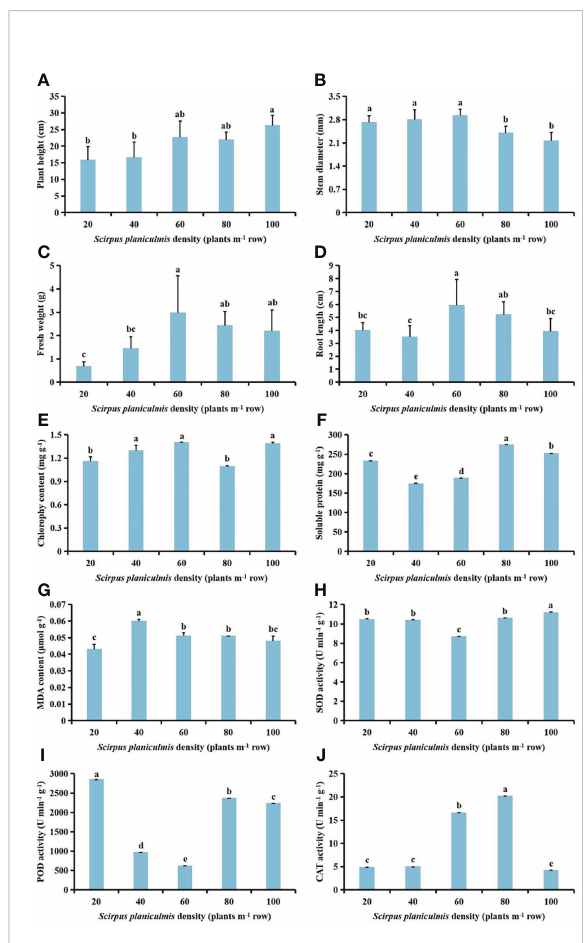
FIGURE 1 Effects of different Scirpus planiculmis densities on (A) plant height, (B) stem diameter, (C) fresh weight, (D) root length, (E) chlorophyll, (F) soluble protein (G) and malondialdehyde (MDA) content, and (H) superoxide dismutase (SOD), (I) peroxidase (POD) and (J) catalase (CAT) activities in S. planiculmis . The mean value ± standard data were presented in the fi gure. Different alphabetical letters indicate the signi fi cant differences between different S. planiculmis density (p